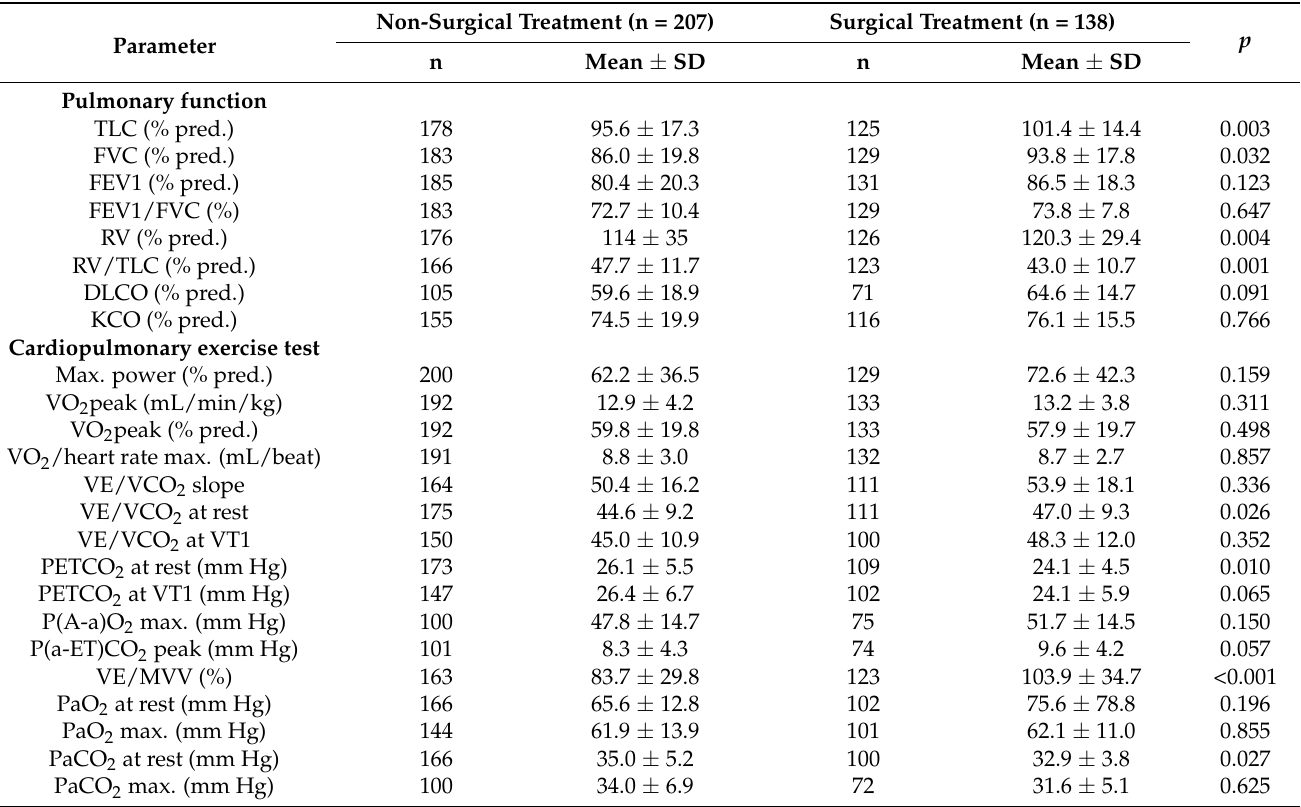
Table 3. Pulmonary Function and Spiroergometric